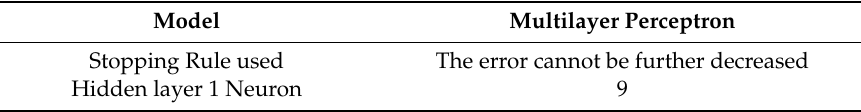
Table 4. Hyperparameters used for ANN in current work.